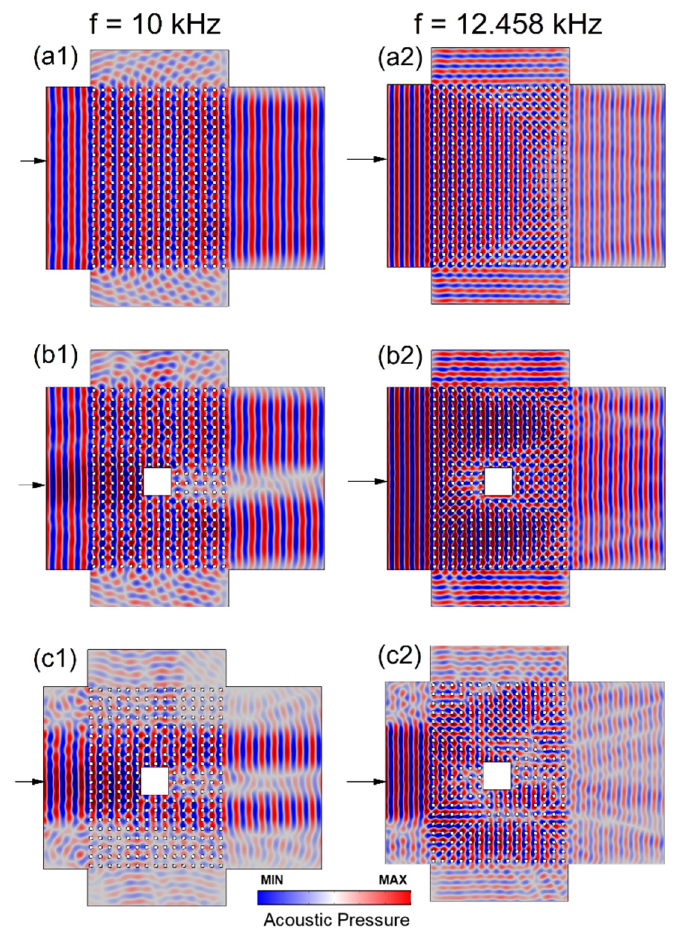
Figure 7. Simulation results showing the absolute pressure field distribution where waves can pass through a waveguide with an embedded obstacle, ( a1 , a2 ) The case where no square steel rod is inserted into the middle of the PnCs slab, and the incident plane wave frequencies are 10 kHz and 12.458 kHz, respectively, ( b1 , b2 ) The same case as that shown in ( a1 , a2 ), except that we inserted a square steel block to be cloaked, ( c1 , c2 ) a similar case here, except that a Gaussian incident beams were used here instead of plane wave for similar frequencies. The steel block has been perfectly cloaked at Dirac frequency for DRA keeping the planar wave-front intact, while the wave-front distorts severely for actuation frequency below Dirac frequency, f = 10 kHz.